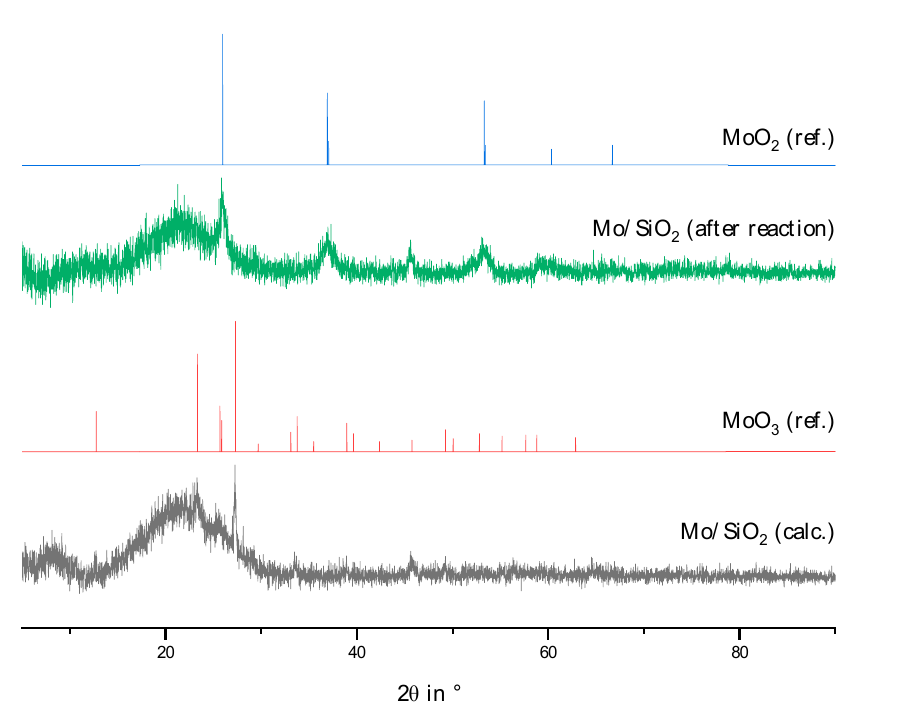
Figure A2. P-XRD of calcined molybdenum catalyst before reaction (calc.) and after reaction.